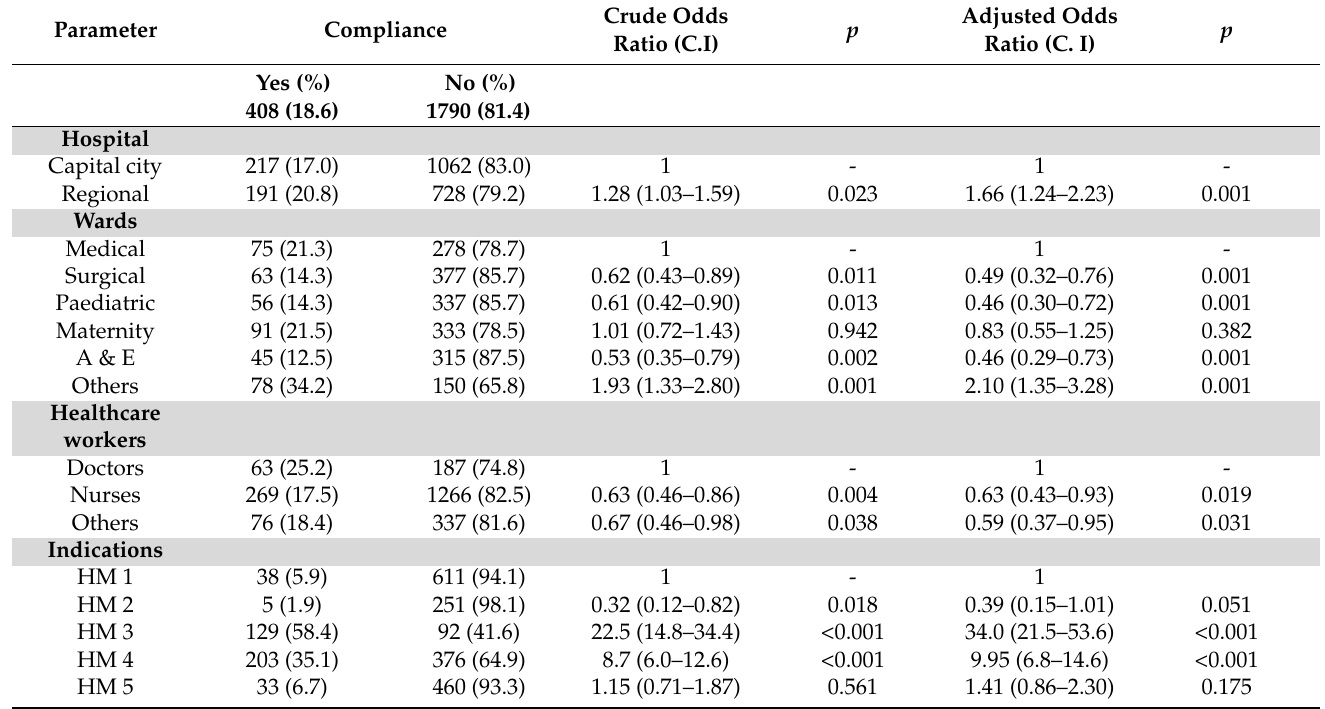
Table 4. Summary of Hand hygiene compliance in the entire sample (N =